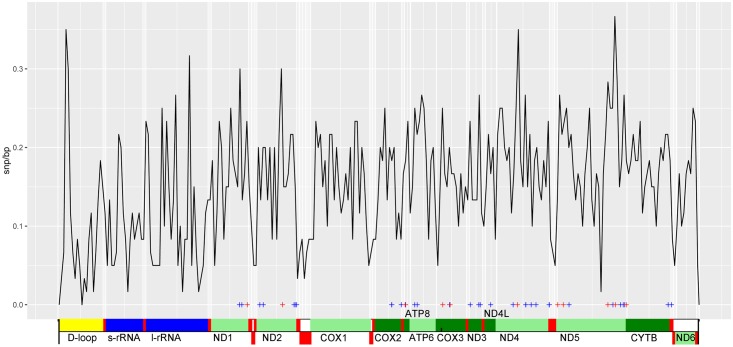
Plot of SNP rates in 60bp-length bins through the whole mitogenome of five hill partridges in this study.Potential positive selective sites detected in PAML are assigned a blue cross, and significant positive selective sites are assigned a red cross.